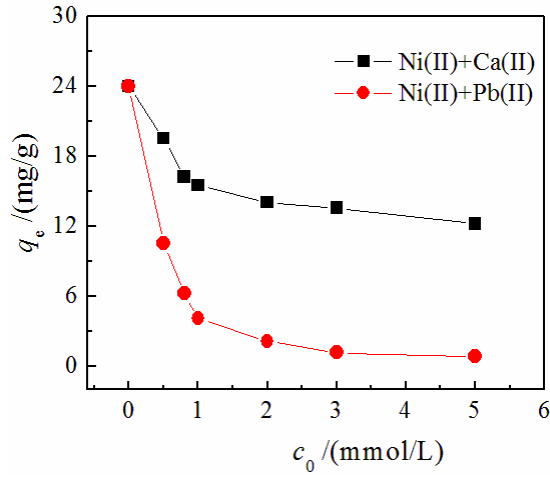
Figure 3. Effect of the coexistent cations on Ni(II) adsorption. c 0 (Ni(II)) = 1.0 mmol/L; t : 360 min;